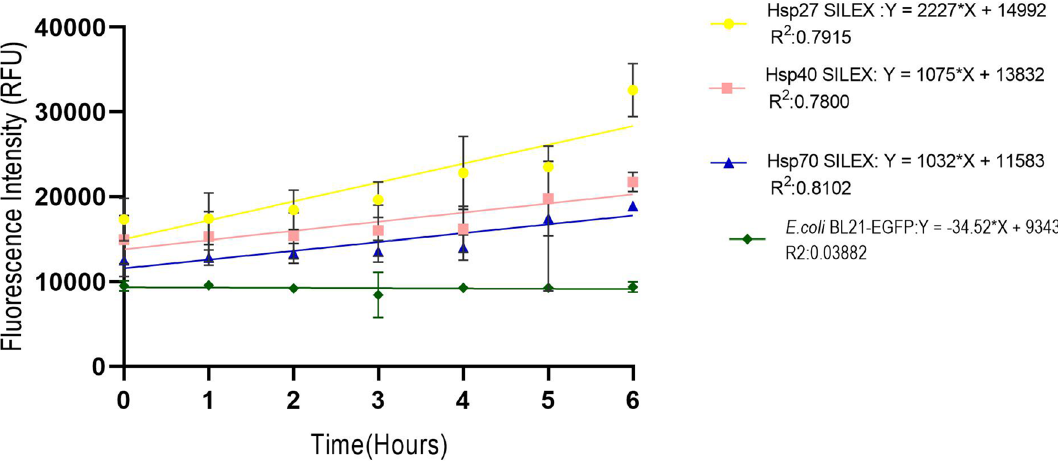
Figure 1. The intensity of fluorescence signals within 6 h incubation. The average of the fluorescence signal intensity for 10 different clones from SILEX systems was plotted for 6 h incubation. Escherichia coli Bl21 (DE3) containing plasmid pET28a-EGFP was evaluated without adding an inducing agent to observe the basal expression of the EGFP protein (Negative control). Data are represented as Mean ± SD from ten independents